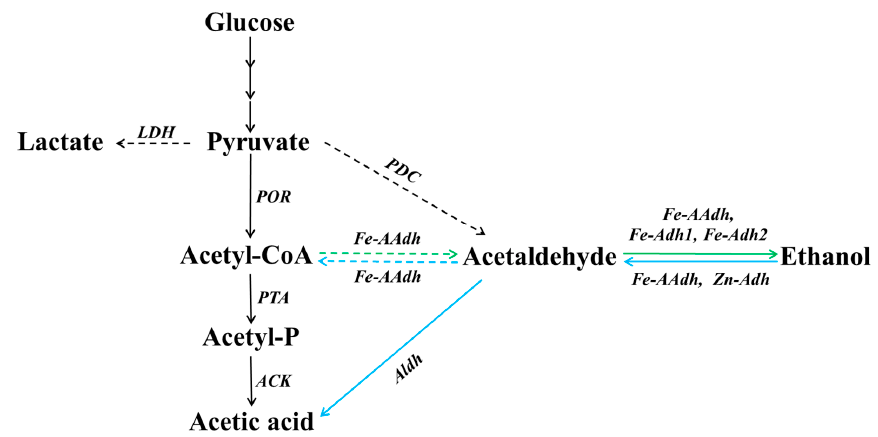
Figure 3. Depicted is the end of ethanol metabolic pathway in T. neapolitana . The dotted line is a weak reaction; the green arrows are the forward reaction (ethanol formation); the blue arrows represent the detoxifying path. LDH: lactate dehydrogenase; POR: pyruvate: ferredoxin oxidoreductase; PDC: pyruvate decarboxylase; PTA: phosphate acetyltransferase; ACK: acetate kinase; Aldh: aldehyde dehydrogenase; Fe-AAdh: bifunctional iron-acetaldehyde/alcohol dehydrogenase; Fe-Adh1, Fe-Adh2, and Zn-Adh: Fe-/Zn- alcohol dehydrogenase. Hyperthermophilic Thermotoga spp. are promising candidates for the metabolic en- gineering of cellulosic ethanol-producing strains. However, Thermotoga spp. are hydrogen producers, and none of them have been found to produce significant amounts of ethanol.